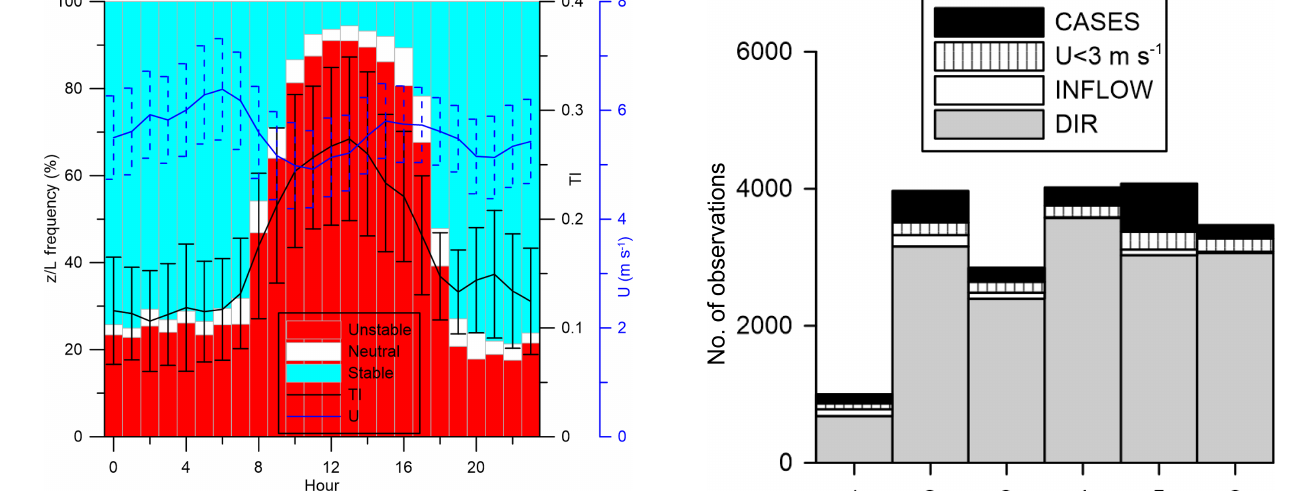
Figure 10. Diurnal variability of meteorological variables from measurements at 78m at Tower 20 for the whole data set (March to June 2017). The frequency of atmospheric stability classes ( z/L < − 0 . 08 is unstable, z/L < | 0 . 08 | is neutral and z/L >0.08 ia stable; bars), wind speed ( U ; blue line with dashed error bars show- ing0.25 ∗ standard deviation) and turbulence intensity (TI; black line with error bars showing 0.25 ∗ standard deviation).